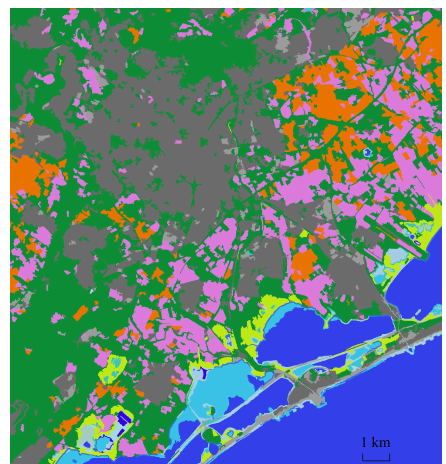
Figure 6. Clustering results for the proposed pipeline without Normalized Difference Vegetation Index (NDVI) branch. The clusters are colored according to the clustering map (b) in Figure 5. 6 clusters of water surface are colored in different shades of